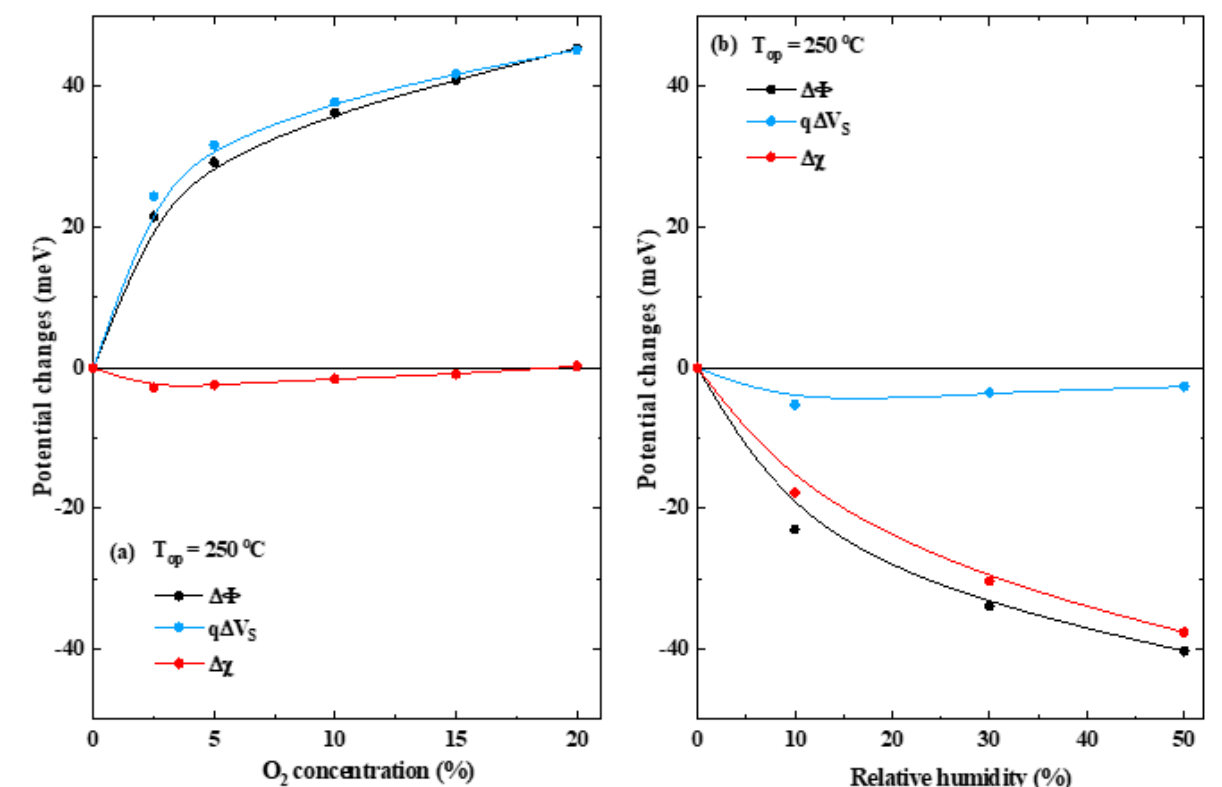
Figure 10. Dependence of the potential changes with respect to O 2 concentration ( a ) and RH level ( b ) for NiO-based gas sensor operated at 250 °C.